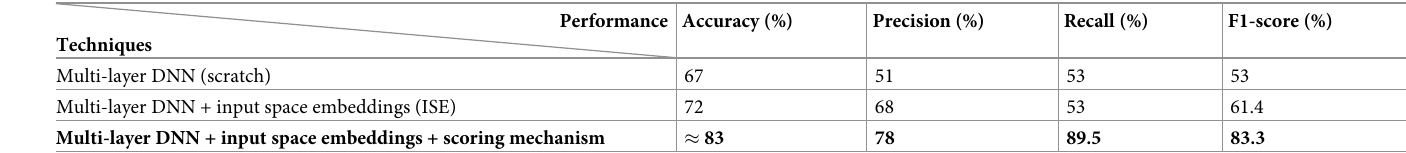
Table 6. Proposed model performance (shown with bold) compared to different techniques on health news tweets dataset.